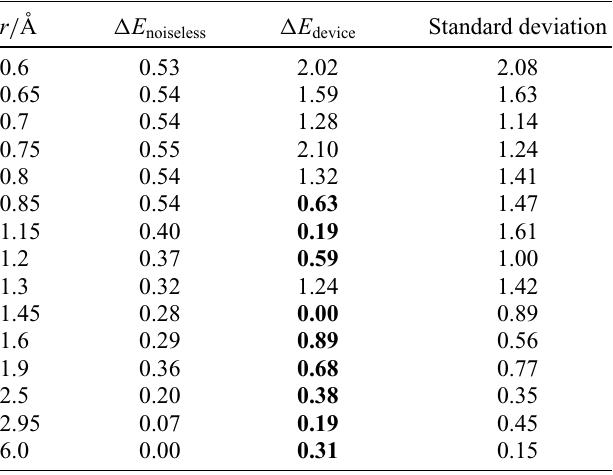
TABLE IV. The errors of 2-QLDSRG(2) energies in m E h (with respect to FCI energies) along the H 2 dissociation curve (Fig. 4). For results from the IBM_LAGOS device, we show the unsigned average energy errors and standard deviations (in m E h ). Unsigned energy errors below 1 m E h are highlighted in bold type.